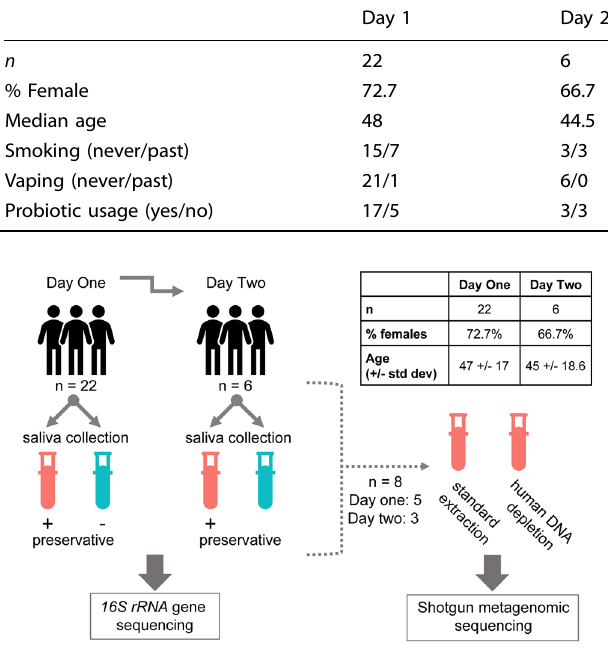
Fig. 1 Saliva collection study design. Each subject provided two saliva samples at the same time, one collected alone and the other collected using the Spectrum sDNA-1000 kit which includes a sample preservative. The order in which samples were collected was randomized between subjects. The six subjects who provided two longitudinal samples provided the second sample the day following their initial saliva sample, using the same collection protocol with samples collected in the same order as on the previous day. For DNA extraction and sequencing differences